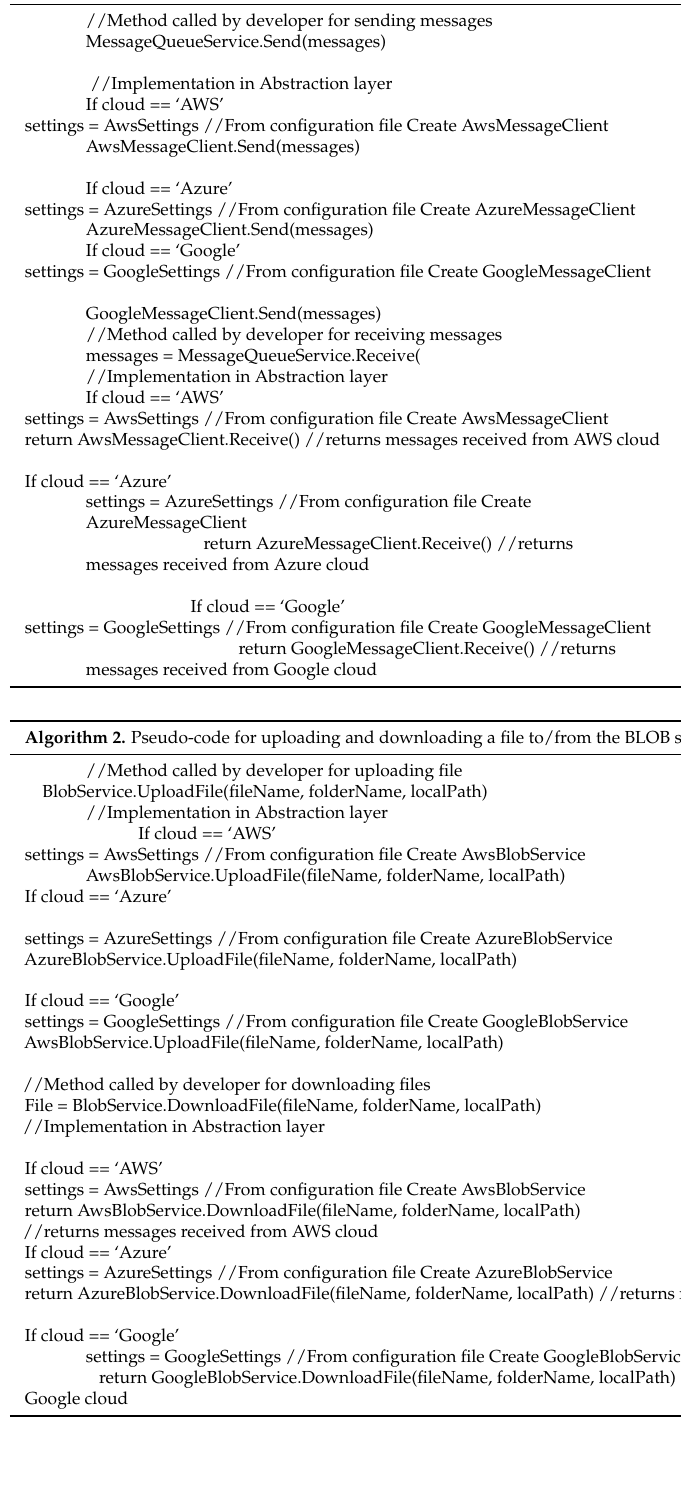
Algorithm 1. Pseudo-code for sending and receiving the messages from the message queue service.